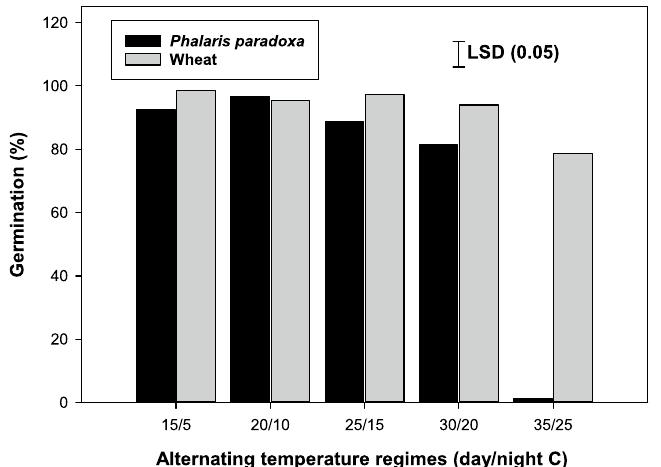
Figure 1. Effect of alternating day/night temperatures (15/5 to 35/25 °C) on germination of Phalaris paradoxa and wheat seeds (incubated for 21 d) under light/dark (12-h photoperiod). LSD: Least significant difference at the 5% level of